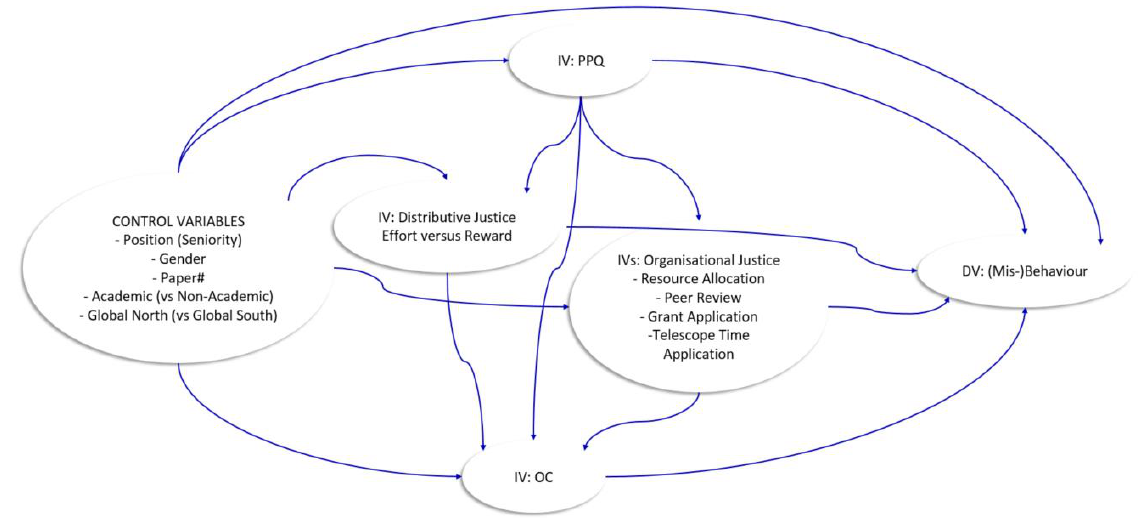
Figure 1. Visualisation of our SEM on the level of latent constructs of our control, independent (IV) and dependent variables (DV). Arrows indicate that a construct (arrowhead) is being regressed onto another construct (arrow start).